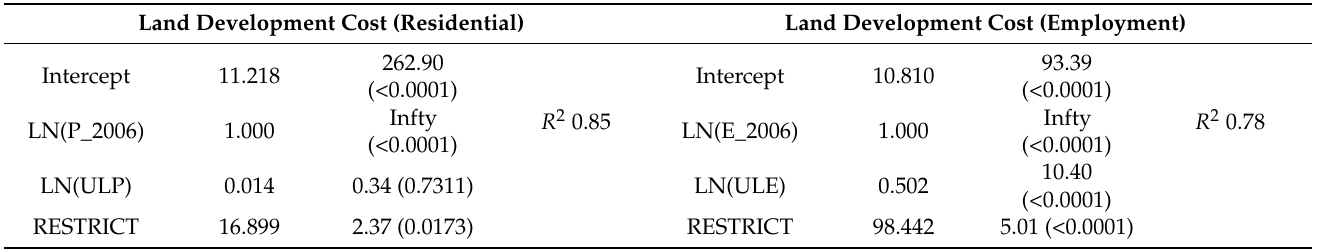
Table 15. Regression Results for Land Development Cost